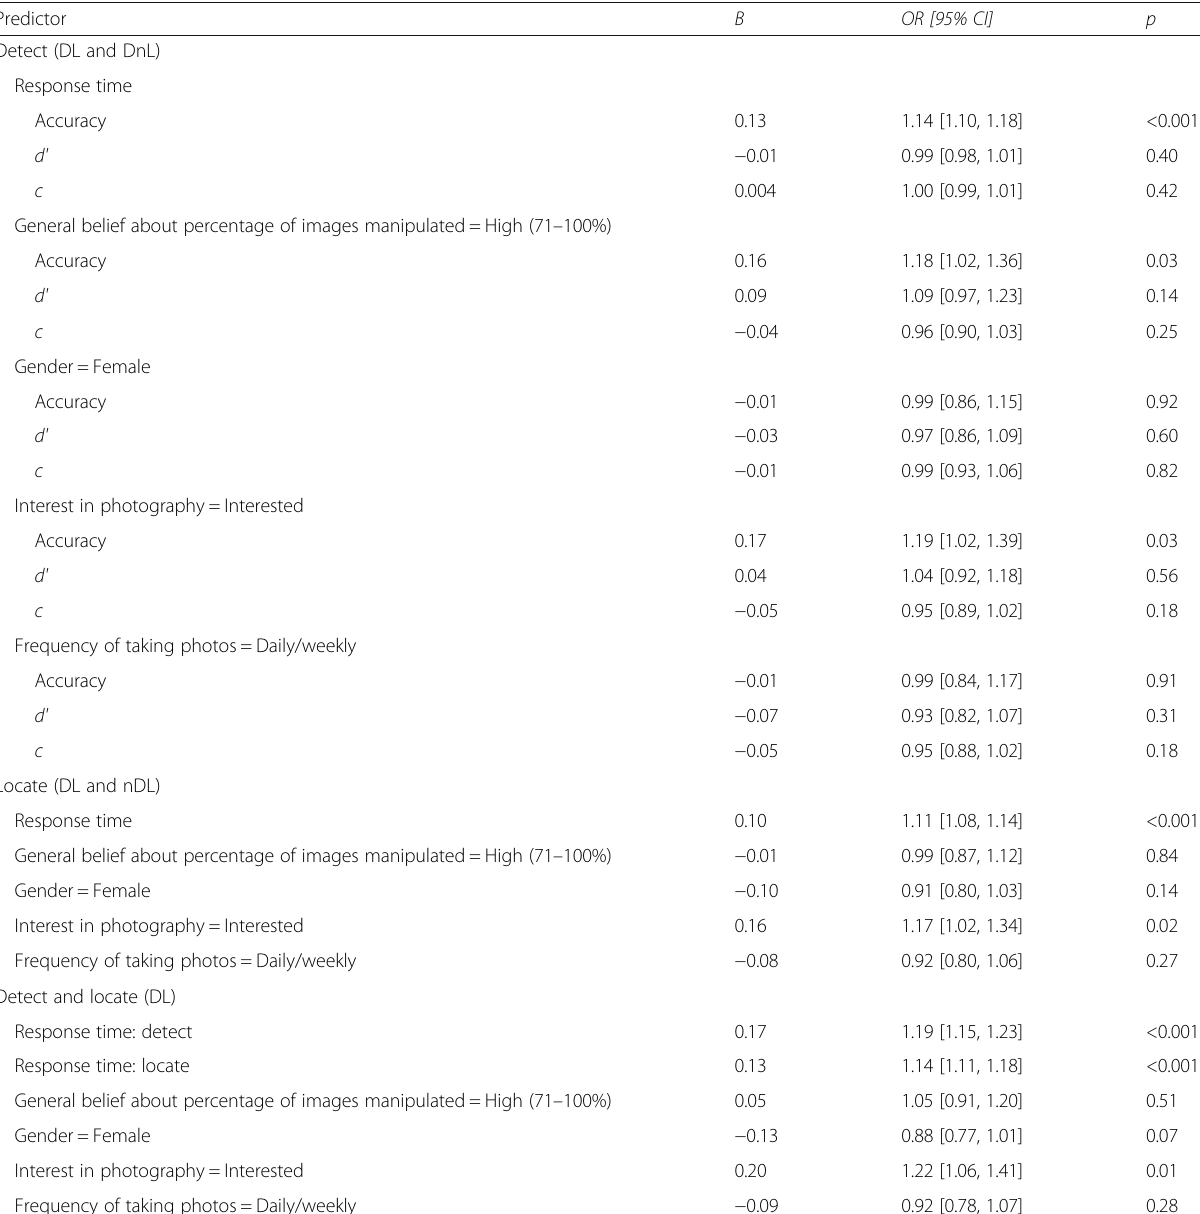
Table 5 Results of the GEE binary logistic and linear regression models to determine variables that predict accuracy in the detect and locate tasks